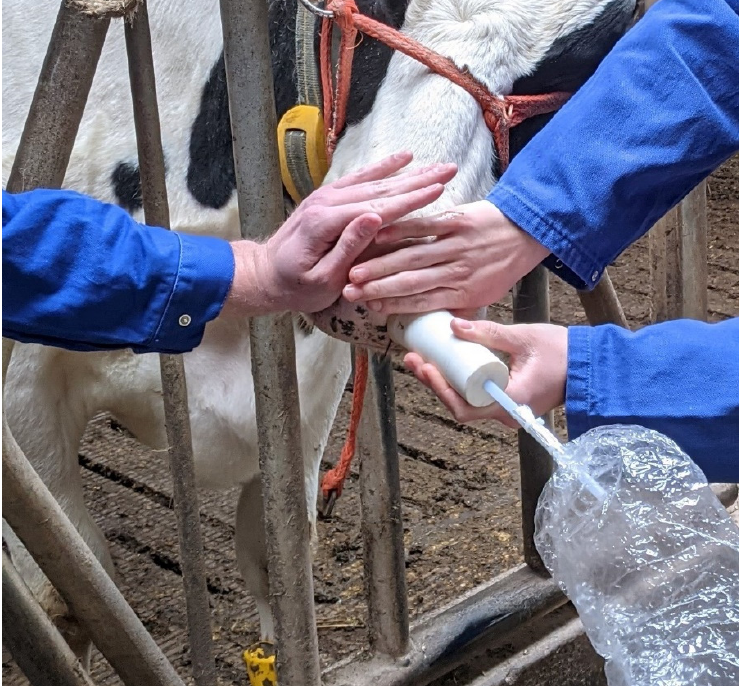
Figure 3. Collection of a breath sample with the nostril sampler and the nalophan bag attached; while taking breath samples, one researcher checked for ructuses at the side of the neck (not shown in the picture).